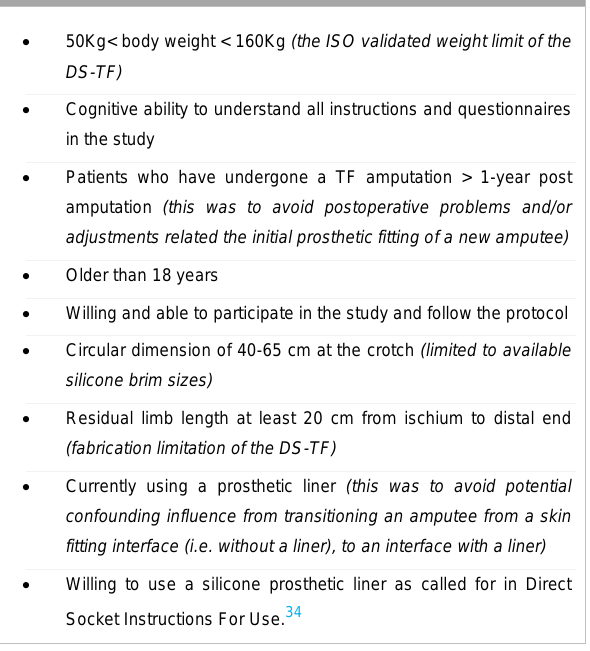
Table 1: Amputee inclusion criteria ( rationale